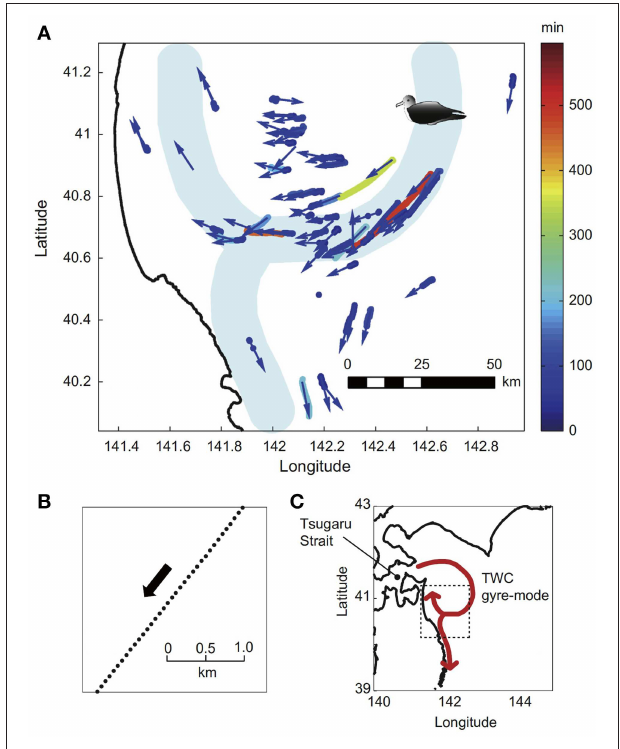
FIGURE 5 | (A) Passive drift movements of streaked shearwaters tracked in September 2010. The color bar indicates duration of drifting on seawater. Most drift tracks were shorter than 100min, but some lasted several hours (pale blue to red tracks). The blue arrows indicate directions of drifting. (B) One example of drifting of a streaked shearwater. The black arrow indicates drift direction. We defined drifting as resting on water for more than 30min with smoothness and consistency of movement direction. (C) The box in (C) is enlarged in (A) . The bold red line in (C) and the pale blue region in (A) are the Tsugaru Warm Current (TWC) on 10 September 2010 derived from ship-board ADCPs reported by the Marine Information Service Office, Japan Coast Guard (JCG) (URL: http://www1.kaiho.mlit.go.jp/). Reprinted from Progress in Oceanography, 122, Ken Yoda, Kozue Shiomi, Katsufumi Sato, Foraging spots of streaked shearwaters in relation to ocean surface currents as identified using their drift movements, 54-64, Copyright (2014), with permission from